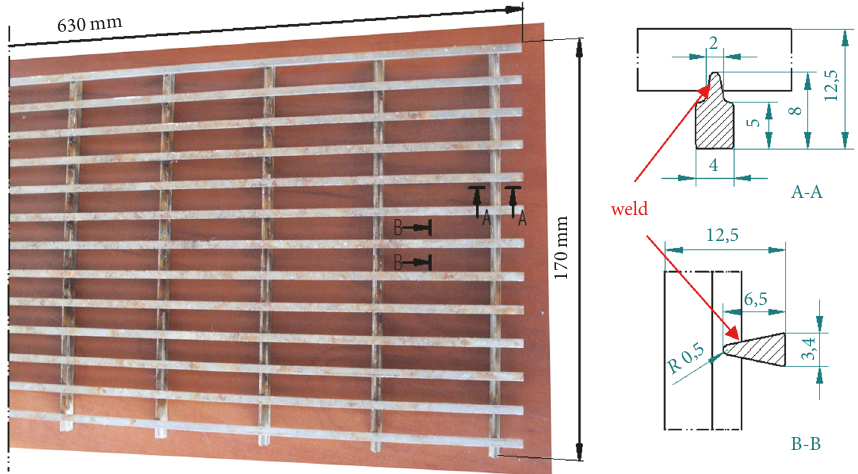
Figure 1: Ventilation grille made by resistance welding of stainless steel rods, dimensions in mm.